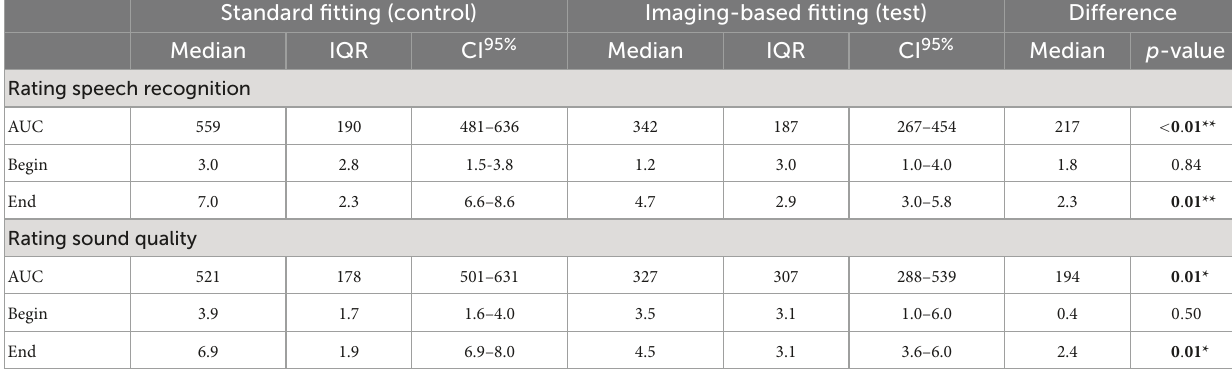
TABLE 4 Preference scales analyzed by ITT for variables AUC (area under the curve), Begin (first fit) and End (after randomization period). Standard fitting (control)